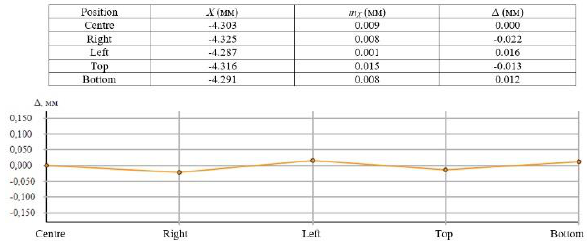
Figure 11. The results of processing photos taken from a distance of 1m and f = 55 mm after the distortion is corrected. The amplitude of the X values shown in Fig.11. is 0.038 mm. The average value of X counts is -4.304 mm and the RMS deviation Figure 8. The results of processing photos taken from a is 0.014 distance of 0.3 m and f = 18 mm without the distortion correction.